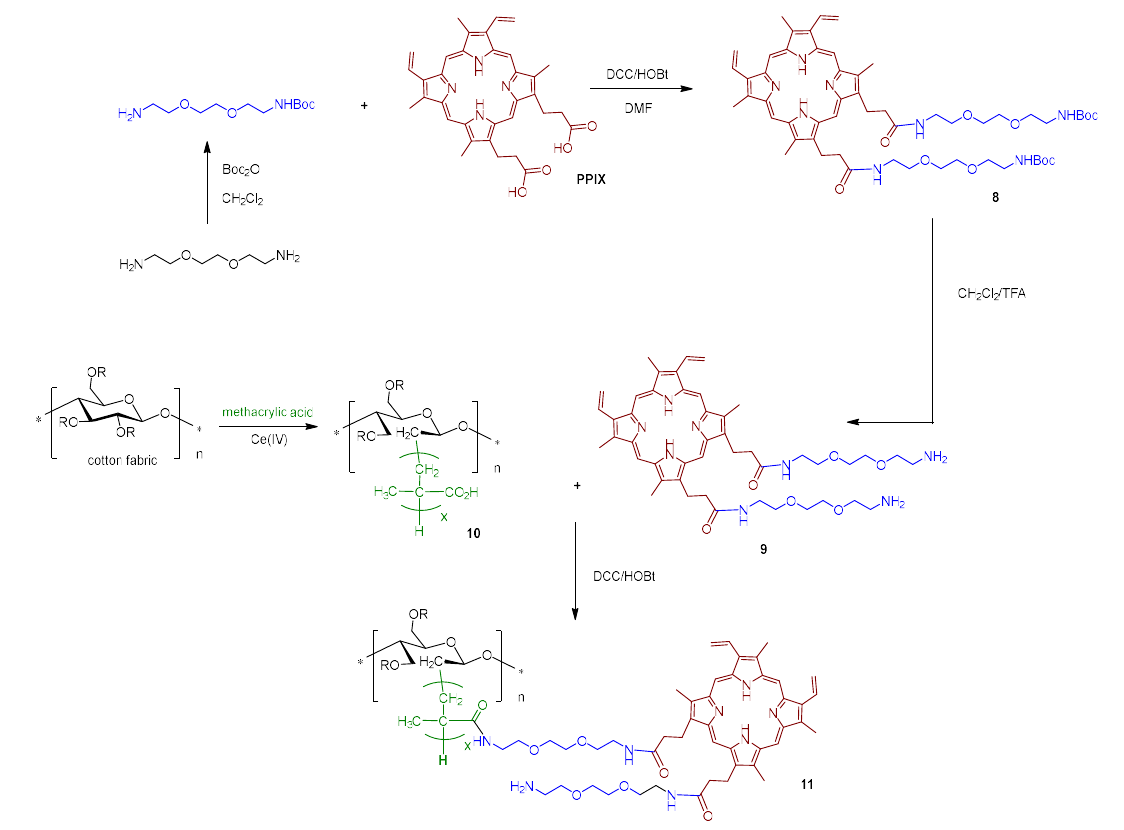
Figure 7. Synthetic strategy adopted by Sol: aminoethyleneglycol spacer arms modified PPIX 9 in cotton/polymethacrylic supports 10 (adapted form Ref. [140]).